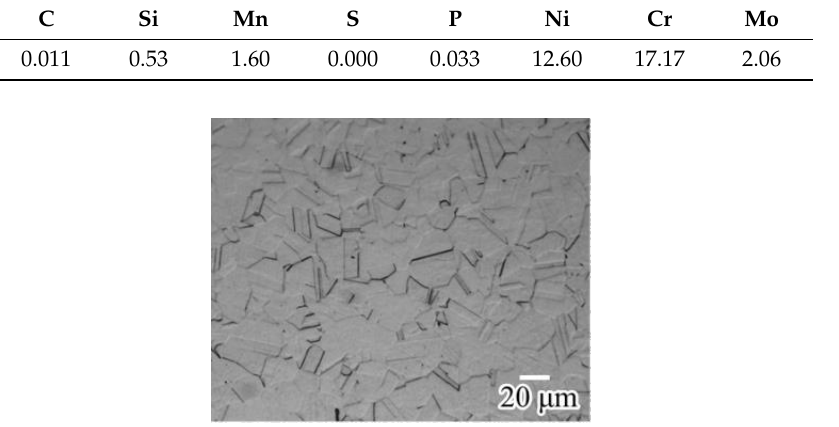
Figure 1. Optical micrograph of surface of specimen.